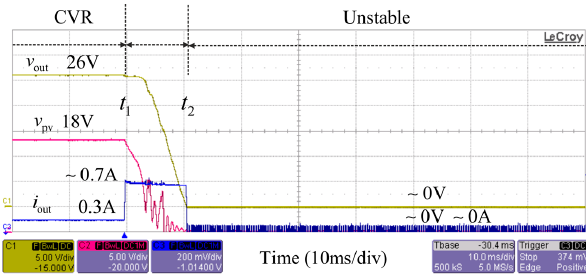
Figure 24. Behavior of boost-converter output voltage ( out v ) and current ( out i ) as well as PV-generator voltage ( pv v ), when the operating point reaches the MPP due to a step change in the output current of the boost converter (i.e., at time 1 t ).